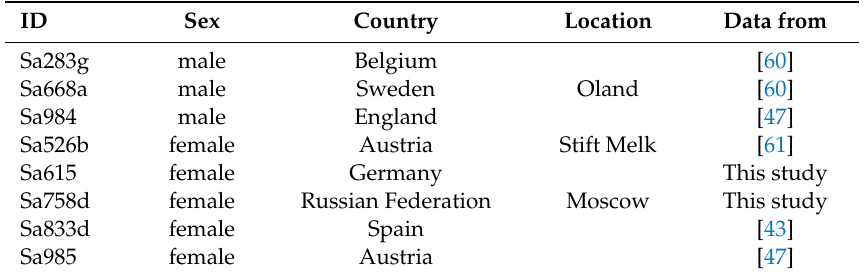
Table 1. S. latifolia samples, for which transcriptome sequence data were analyzed in this study. ID